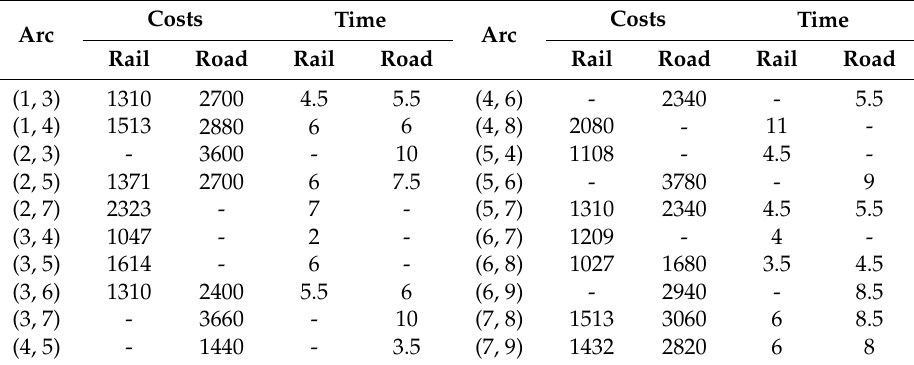
Table 2. Transportation service costs and times en route.